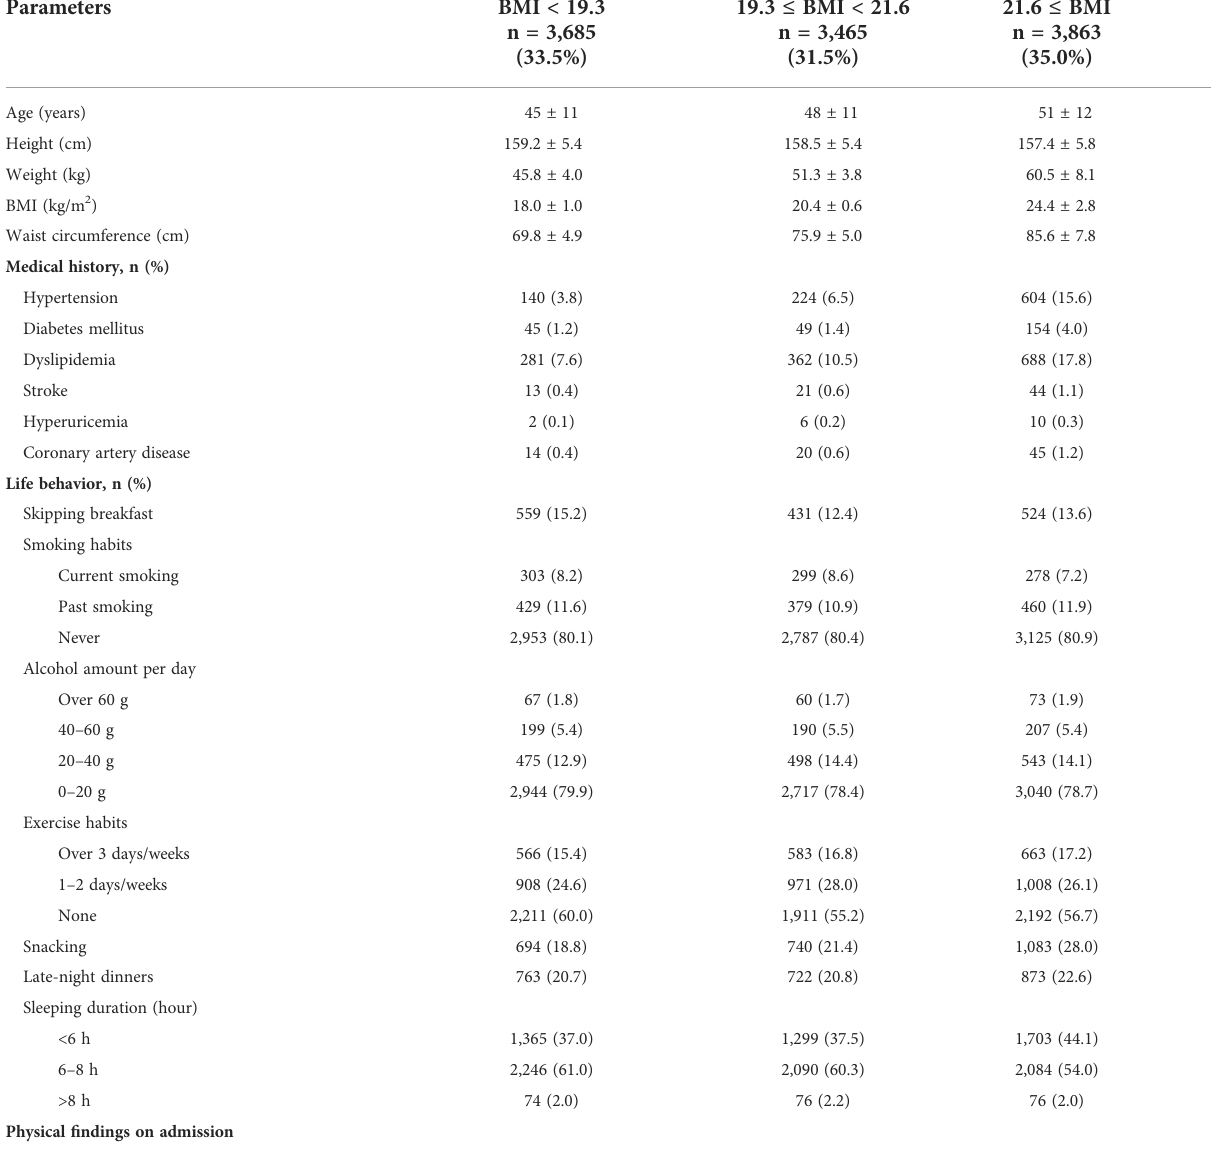
TABLE 1B Clinical characteristics of 11,013 females strati fi ed by BMI